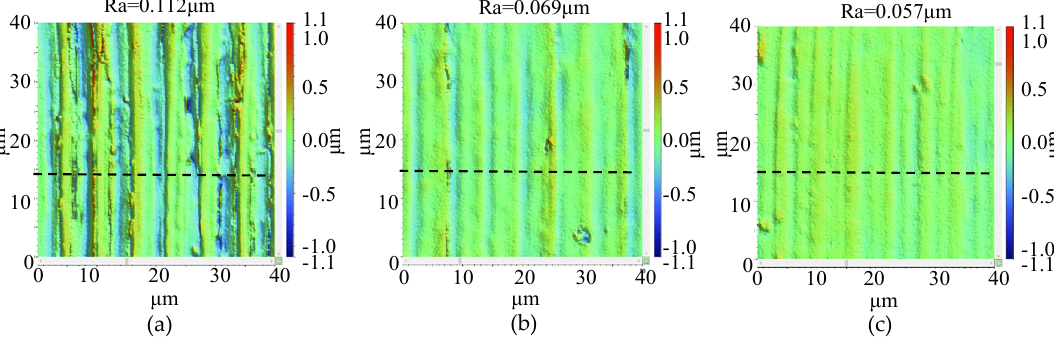
Figure 2. The surface morphology of the milled BMG workpiece with different milling distance.